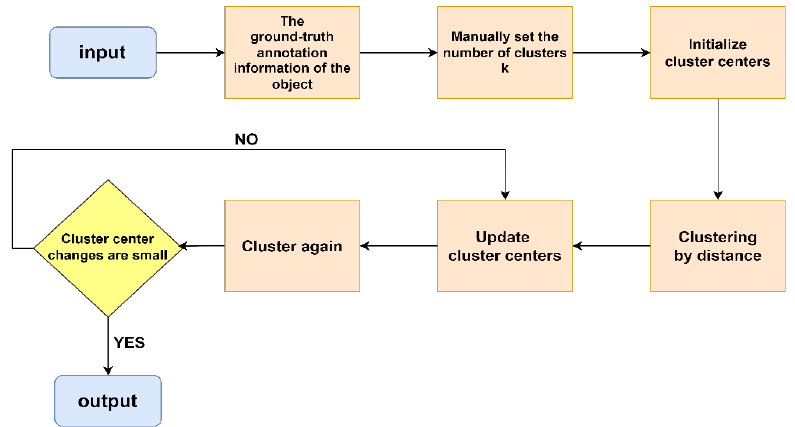
Figure 7. K-means clustering algorithm flow chart.